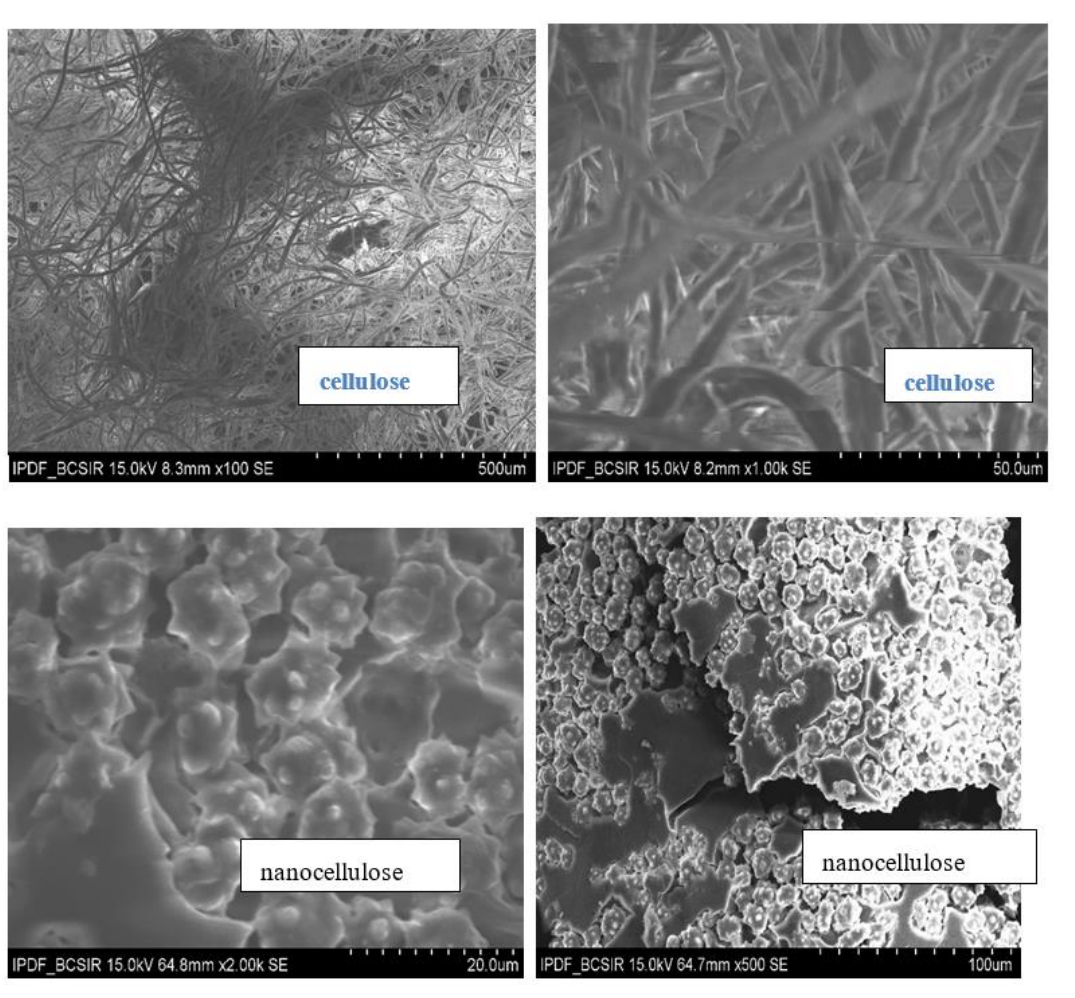
Figure 3. SEM of cellulose and nanocellulose.